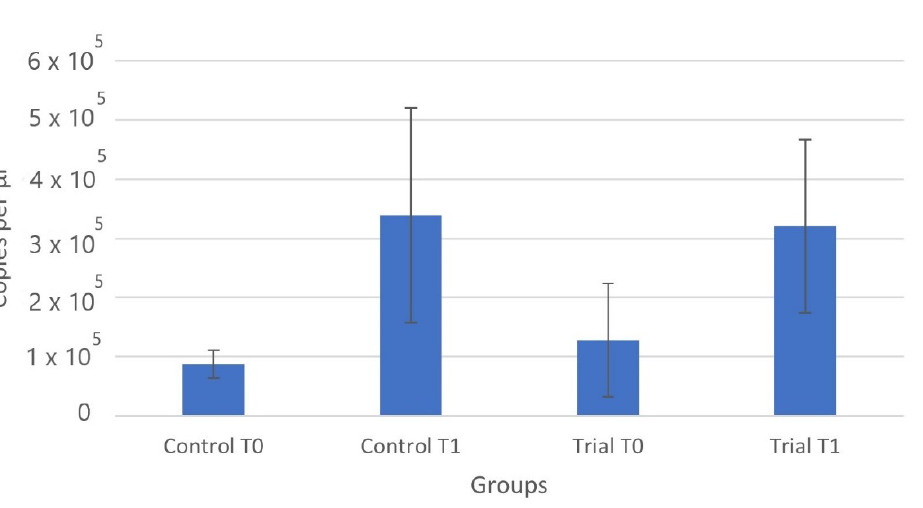
Table 6. Descriptive statistics of the total bacterial count expressed as copies/microlitre.